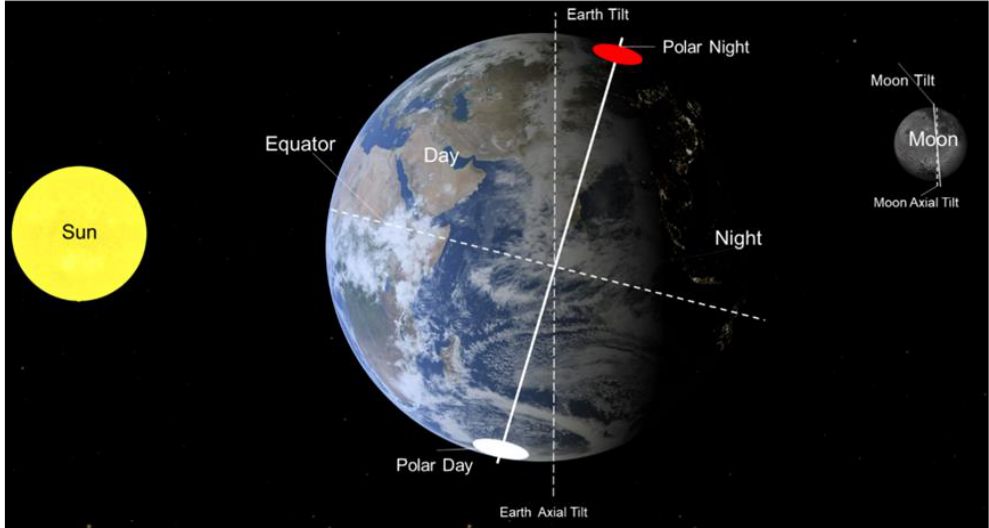
Figure 1. Moonlight, the light source in the Arctic during the polar night period.